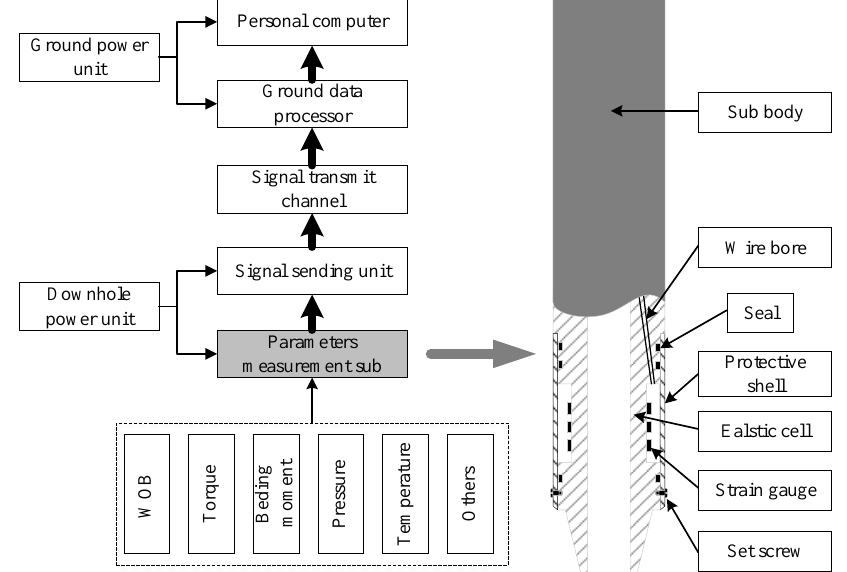
Figure 2. Schematic diagram general parameters measurement system and measurement sub.